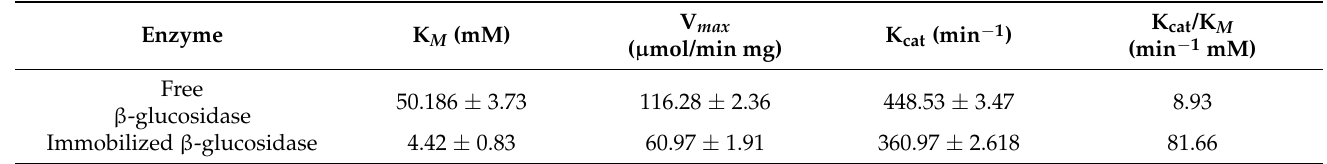
Table 3. Kinetic parameters of free and immobilized recombinant β -glucosidase.